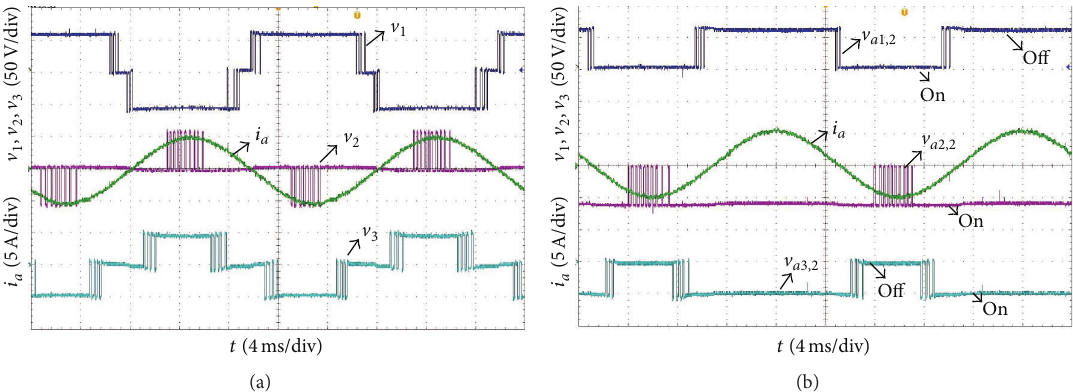
Figure 9: Waveforms of the converter with simplified FS-MPC: (a) Output voltage of each cell. (b) The collector-emitter voltage waveforms for one IGBT of each cell (the upper IGBT of right